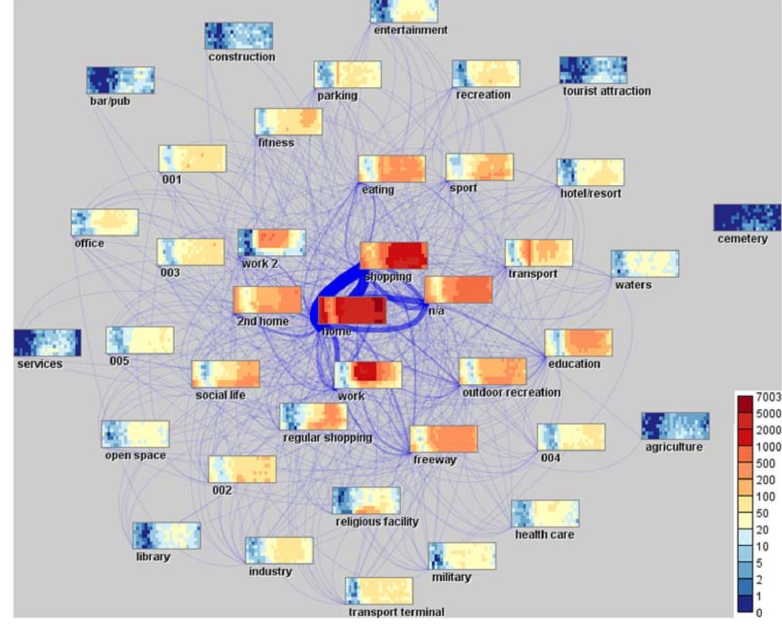
Figure 10. Semantic space map for visualization of mobility flows